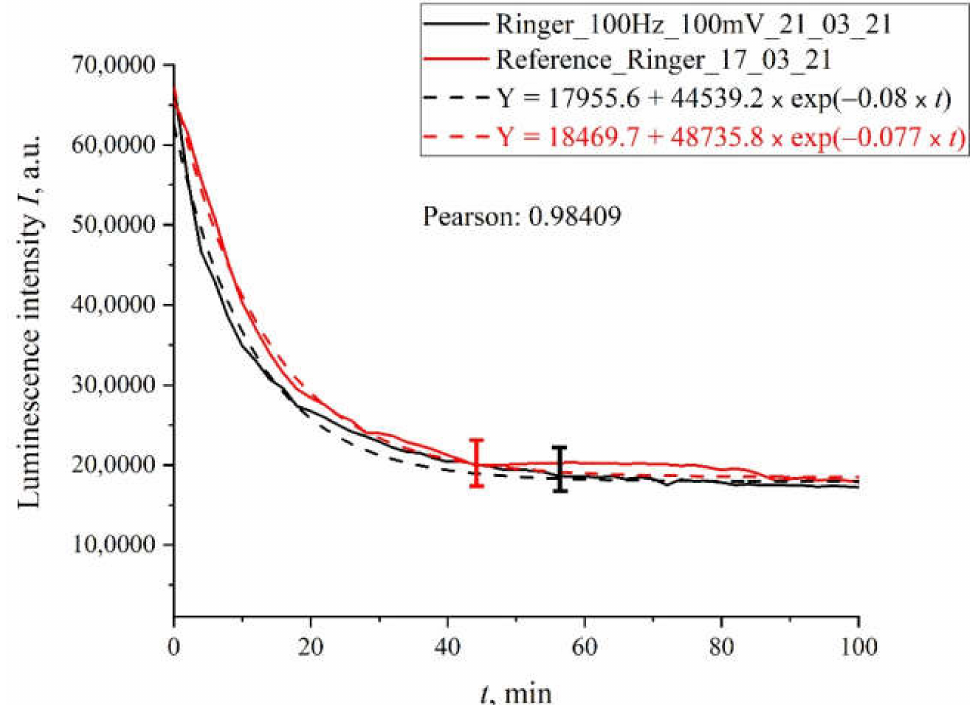
Figure 7. The results of processing with pulses of amplitude 100 mV at a repetition rate of 100 Hz for Ringer’s